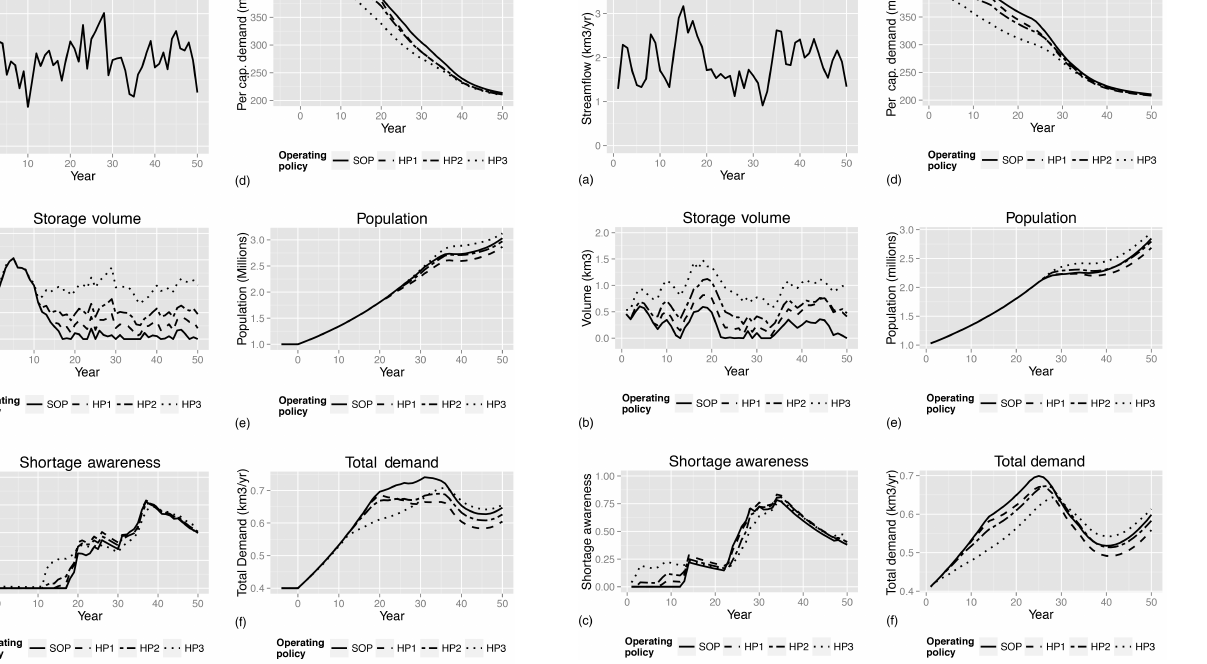
Figure 6. Model results, trial 1: (a) annual streamflow, (b) reser- voir storage volume, (c) public shortage awareness, (d) per capita demand, (e) annual city population, (f) total demand.